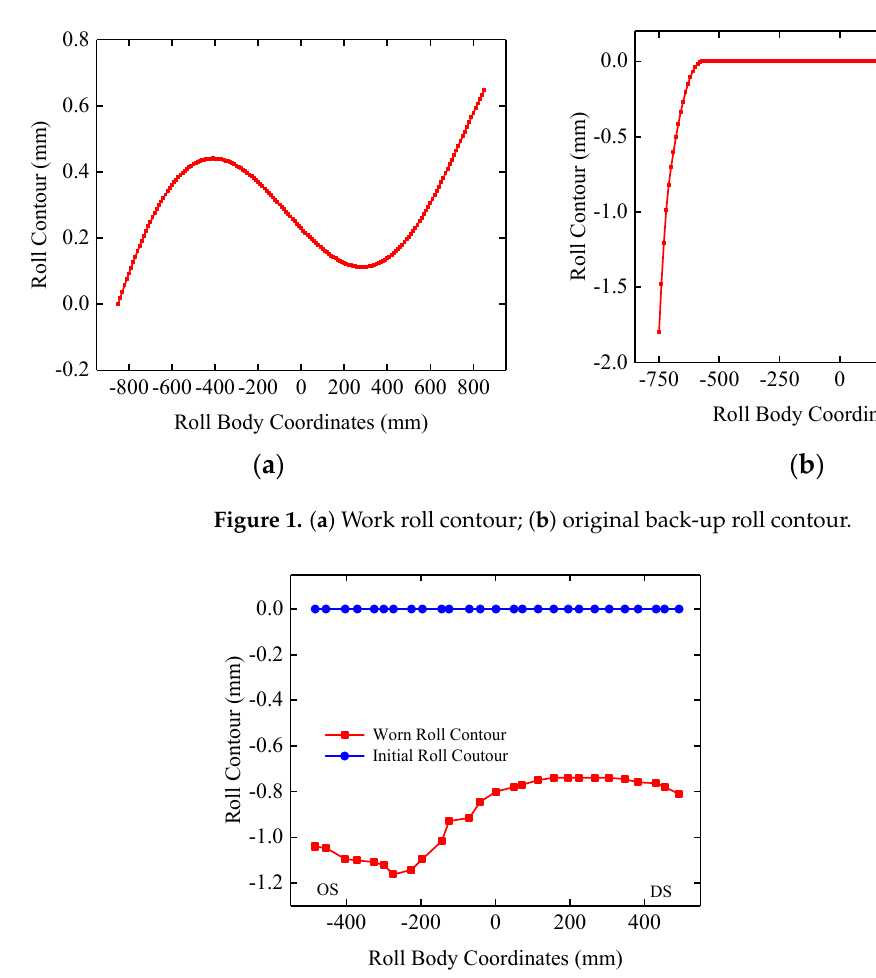
Figure 2. Typical worn roll contour of back-up roll. During the worn roll contour tracking process, a spalling accident occurred on the upper back-up roll at the F2 stand. As shown in Figure 3, the spall center is located about 150 mm away from the drive side. Spalling occurs when wear is severe.